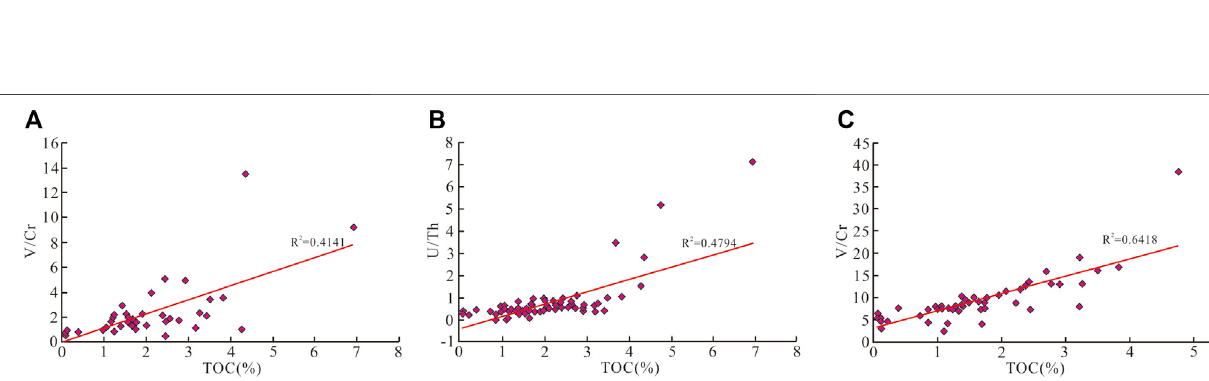
FIGURE 7 | Distribution of porosity and permeability of the Wufeng Formation Long 1 1 sub-member in the study area. (A) Porosity of each sub-member. (B) Porosity of the single well. (C) Permeability of each sub-member. (D) Permeability of the single well.